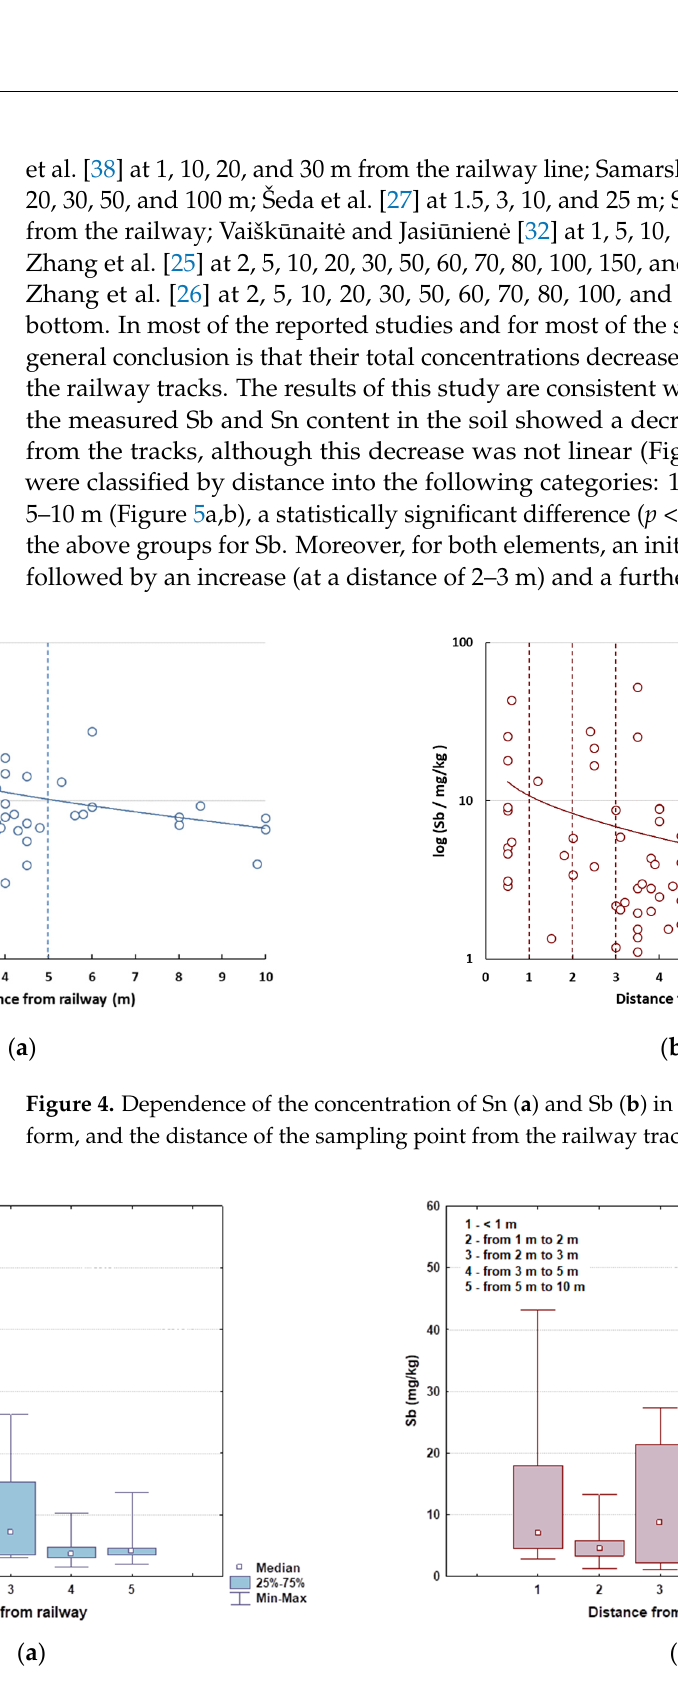
Figure 5. Dependence of concentration of Sn ( a ) and Sb ( b ) in soil and the distance categories of the sampling point from the railway tracks (boxplots were obtained by Kruskal–Wallis ANOVA followed by a pairwise comparison using Dunn’s method, with the significance level set at p < 0.05).